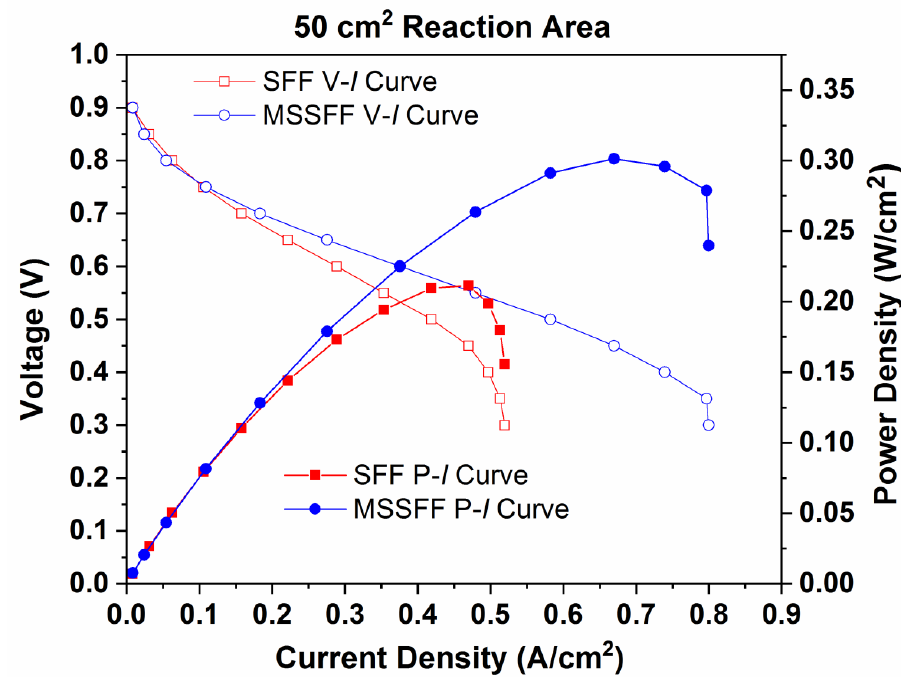
Figure 9. Performance (P–I) curves and Polarization (V–I) curves for SFF and MSSFF on cathode side with 50 cm 2 reaction area.